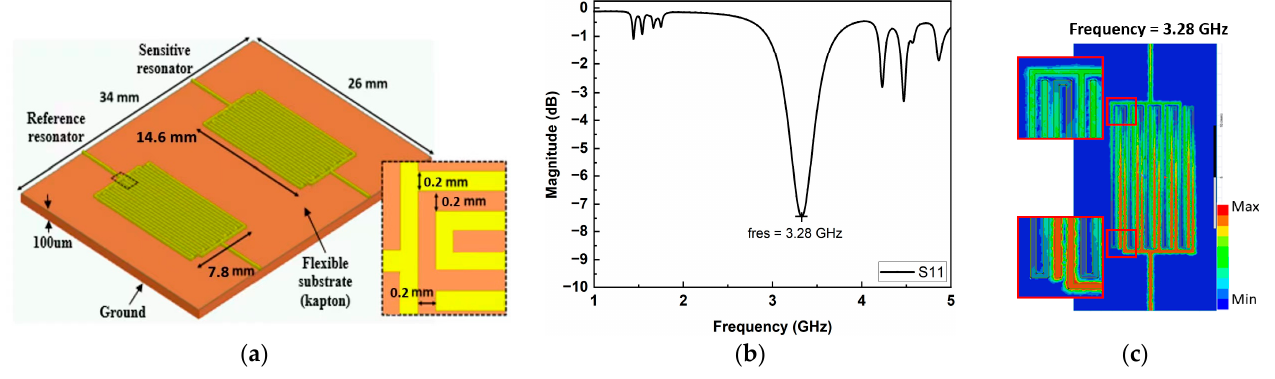
Figure 3. Design of the microwave resonators: ( a ) microstrip resonators geometry, ( b ) simulation result of the S 11 and S 21 parameters of the bare resonator and ( c ) cartography of the electric field distribution at resonance frequency.